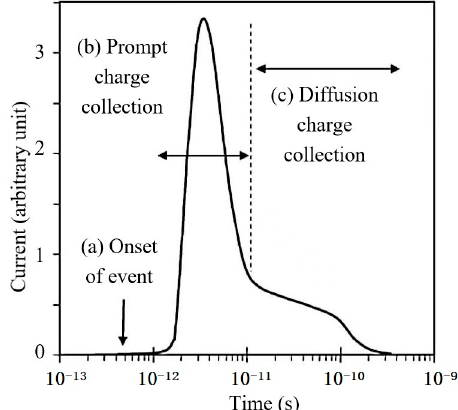
Figure 7. Three stages of transient current of transistor sensitive nodes.